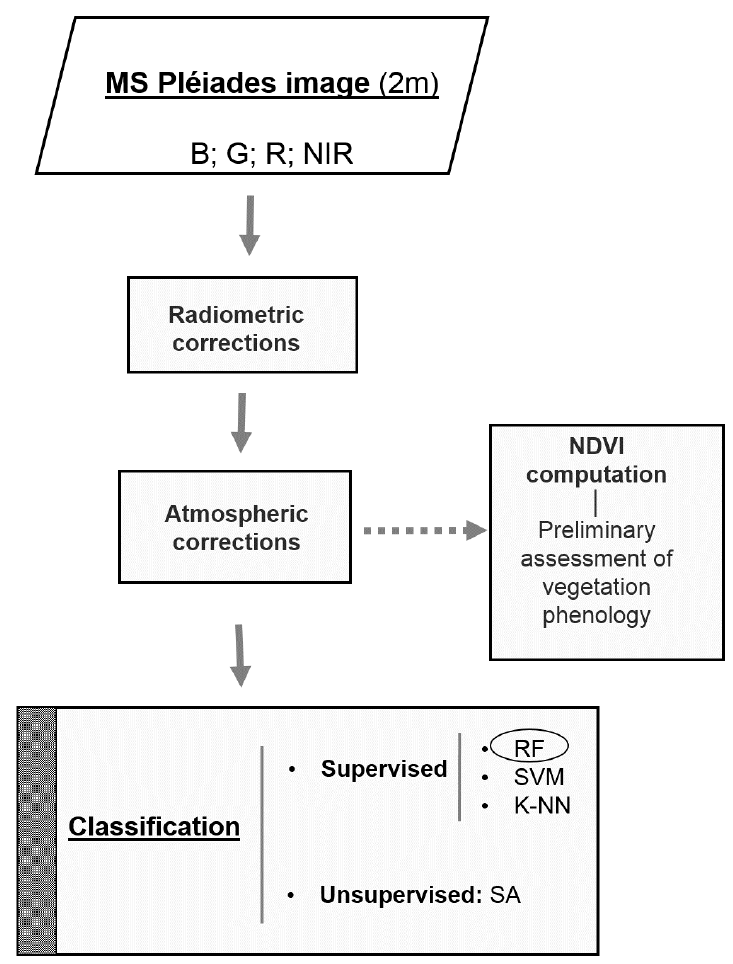
Figure 3. Flow chart of the image processing steps.